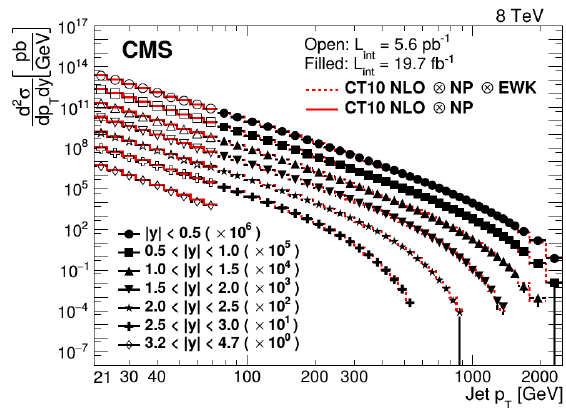
Figure 6. Di ff erential cross sections of inclusive jet production as function of jet p T , see Ref. [9]. The filled markers are mea- sured by all CMS Calorimeters with η < 3, while the open mark- ers by the HF